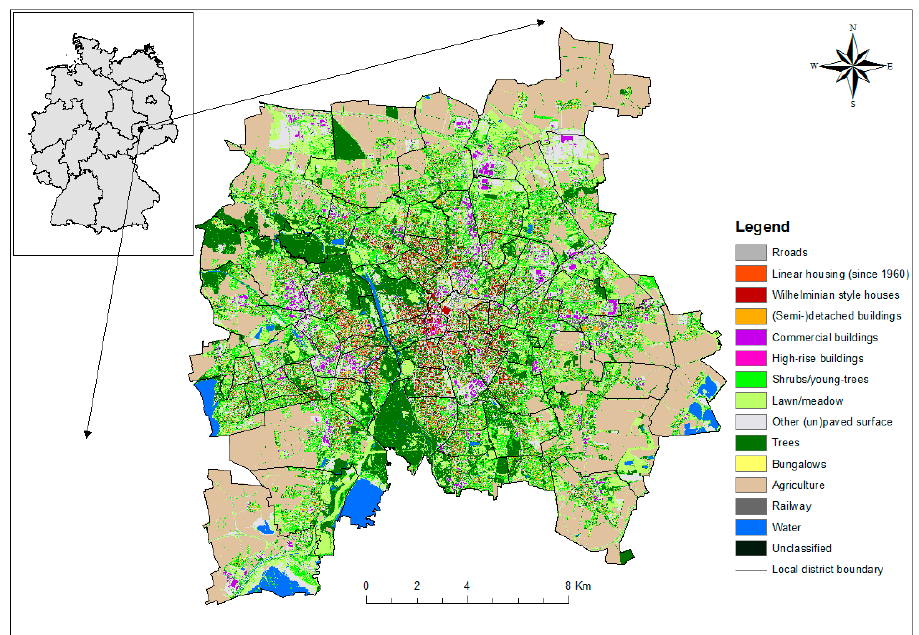
Figure 5. The location and Land Use and Cover map of the illustrative case at urban scale, in the City of Leipzig, Germany.